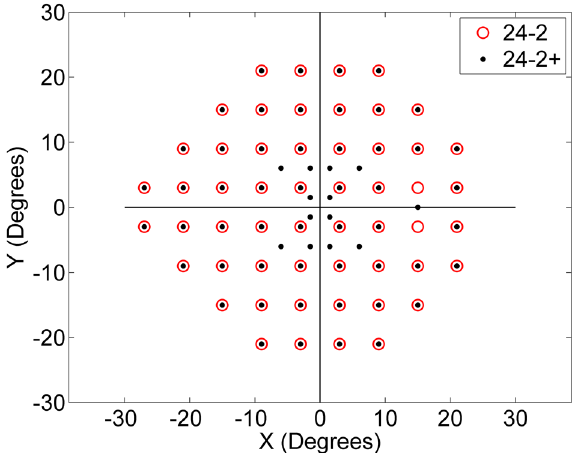
Figure 4. Comparison between standard 24-2 and 24-2+